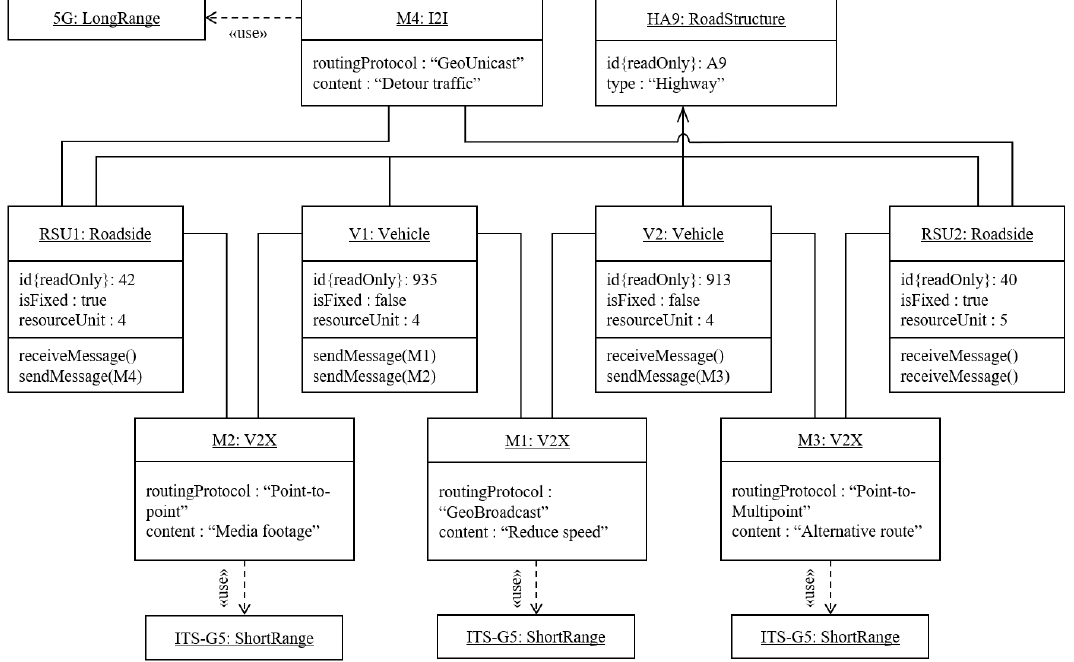
Figure 6. Object diagram corresponding to the scenario shown in Figure